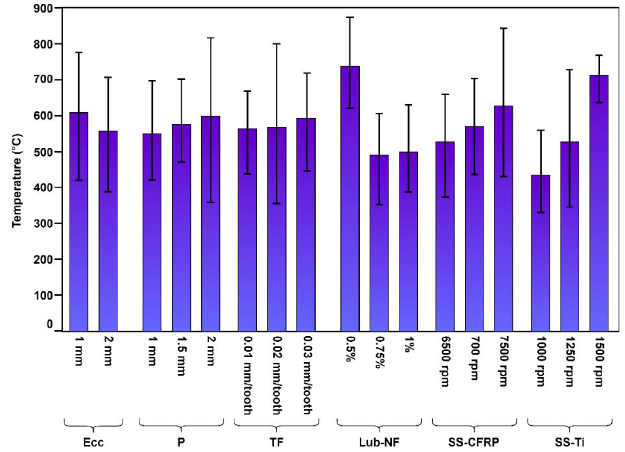
Figure 12. Trend plot of temperature during processing. Table 9. Analysis of variance of maximum temperature of Ti.